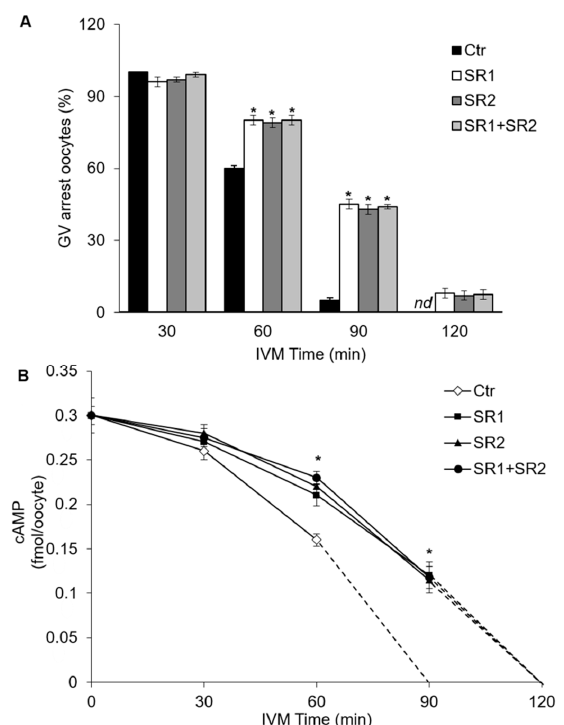
Figure 4. Effects of CBRs antagonists on the kinetics of oocyte germinal vesicle breakdown (GVBD) and on cAMP concentration. ( A ) Oocyte–cumulus cell complexes (OCCs) were matured in vitro in the presence of 0.05% DMSO (Ctr) or SR1, SR2, and SR1 + SR2 (0.5 µM) for 30, 60, 90, and 120 min. Data are expressed as percentage of GV arrested/total oocytes. nd : not detectable ( B ) cAMP concentration (fmol/oocyte) was assayed in oocytes cultured in vitro for 30, 60, 90, and 120 min as Ctr or in the presence of SR1, SR2, and SR1 + SR2 (0.5 µM). Data are expressed as mean ± SEM of 4 independent experiments. * p < 0.05 vs Ctr oocytes of the same experimental group. nd : values below the limit of detection of the assay (0.1 pmol /